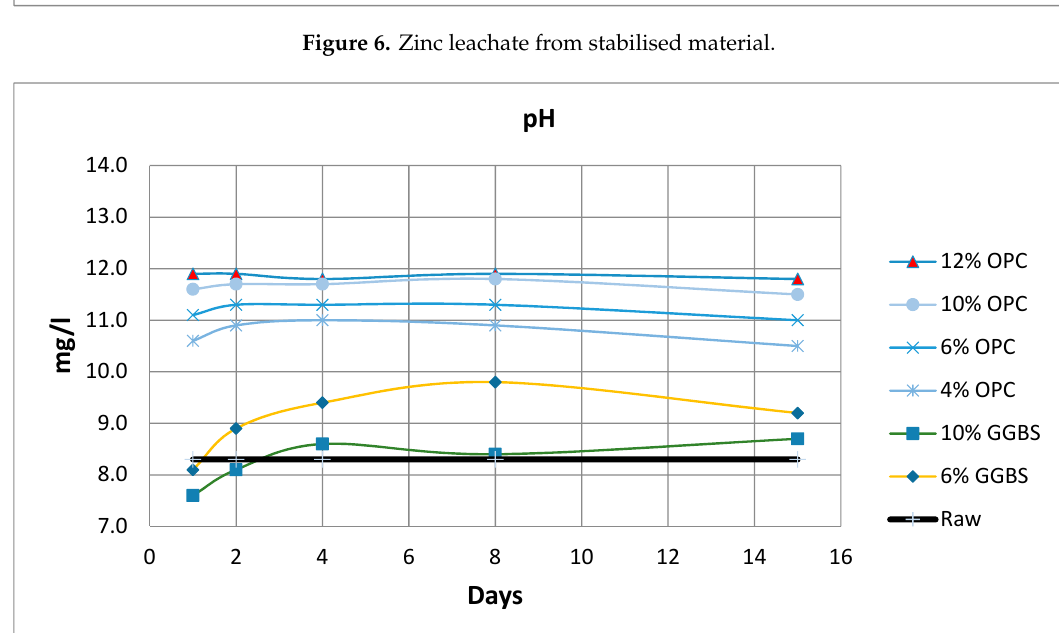
Figure 7. pH of stabilised material.